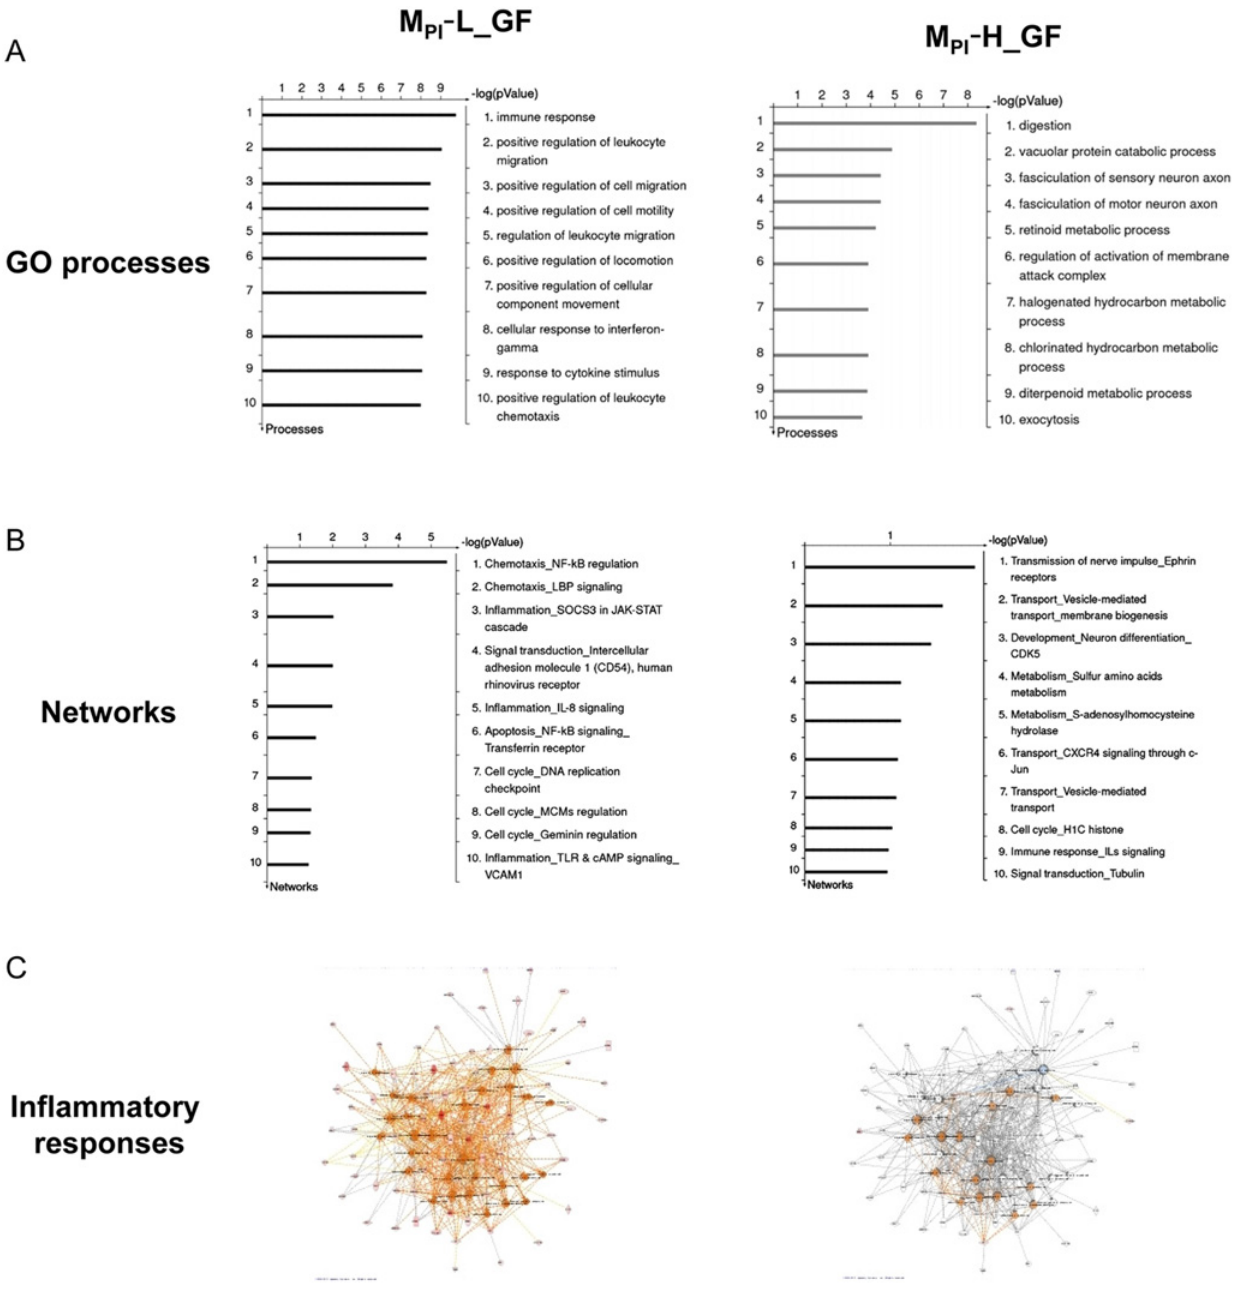
Fig 3. MetaCore gene enrichment analysis of ileum microarray data representing microbiota effects in preweaned M PI -L and M PI -H-gnotobiotic mice. M PI -L and M PI -H induced differentially expressed genes were analyzed by GeneGO MetaCore software. Panel A: Top 10 overrepresented GO biological processes in preweaned M PI -L, H vs GF mice. Panel B: Top 10 scored overrepresented networks in preweaned M PI -L, H vs GF mice. Panel C: Comparison of the differentially expressed genes in M PI L_GF and M PI -H_GF presented in inflammatory response-related networks using the IPA program. Orange line: activation; Blue line: inhibition; Grey: not present.